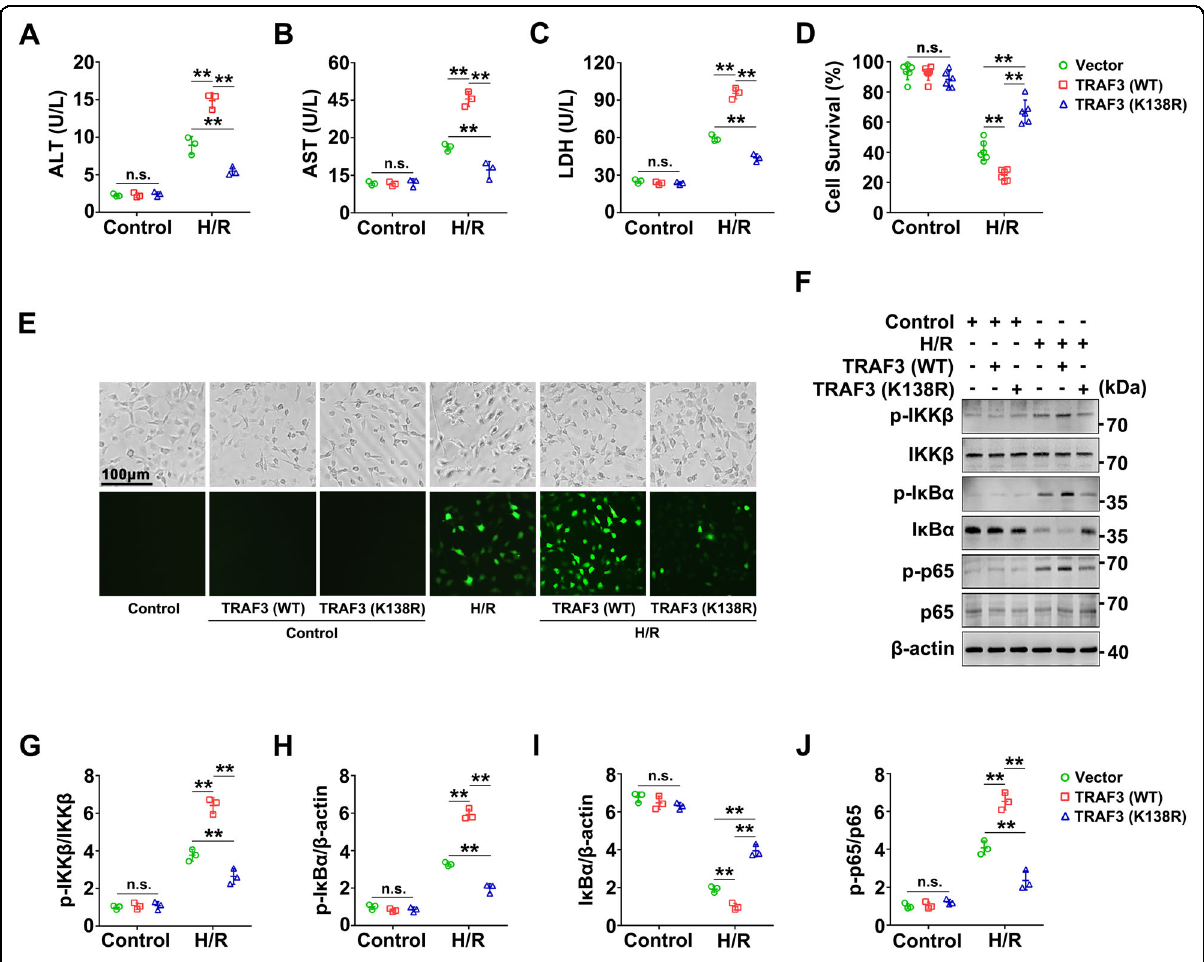
Fig. 7 TRAF3 Lys138 mutants reduce the injury of BRL-3A cells with H/R. BRL-3A cells transfected with TRAF3 Lys138 mutants (K138R) plasmids or the corresponding WT and vector plasmids as indicated, and the cells were cultured under normal or H/R conditions. The following analysises were performed. A – C ALT, AST, and LDH activities in the culture medium. Pretreated BRL-3A cells were incubated under normal or H/R conditions. Data are mean ± SD, n.s., not signi fi cant; ** P < 0.01 by two-way ANOVA followed by Tukey ’ s test. n = 3 per group. D CCK-8 assay was used to examine cell survival. Data are mean ± SD, n.s., not signi fi cant; ** P < 0.01 by two-way ANOVA followed by Tukey ’ s test. n = 6 per group. E ROS in BRL-3A cells. ROS staining was performed to evaluate the level of ROS in BRL-3A cells, and the stained fl uorescence was observed using a fl uorescence microscope. The cellular morphology and structure of BRL-3A cells by bright image investigation. F – J Proteins levels of p-IKK β , IKK β , p-I κ B α , I κ B α , p- p65, p65 in BRL-3A cells were evaluated using western blot ( F ) and quanti fi ed using a Gel-Pro Analyzer ( G – J ). Data are mean ± SD, n.s., not signi fi cant; ** P < 0.01 by two-way ANOVA followed by Tukey ’ s test. n = 3 per Table 1 Donor and recipient information for liver transplantation. Donor Recipient